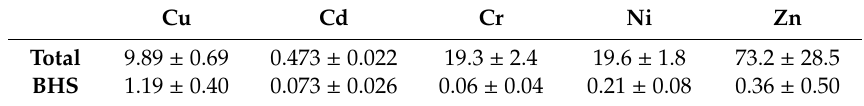
Table 2. Total and extracted bulk soil humic substances BHS heavy metal concentrations (mg / kg, n =